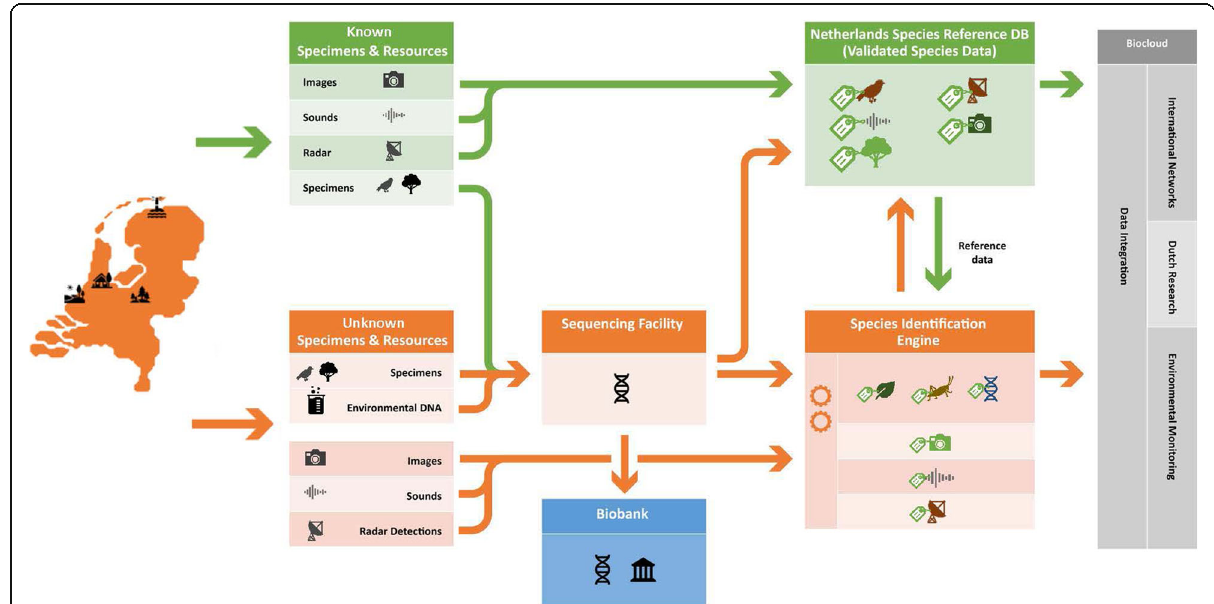
Fig. 12 Data flow in the ARISE